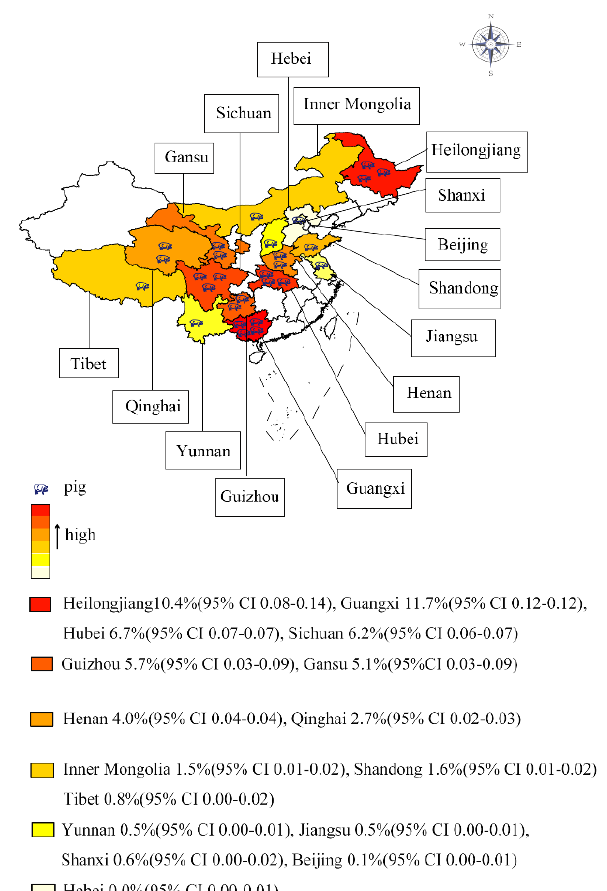
Figure 3. Distribution map of Trichinella spiralis in domestic pigs in China.